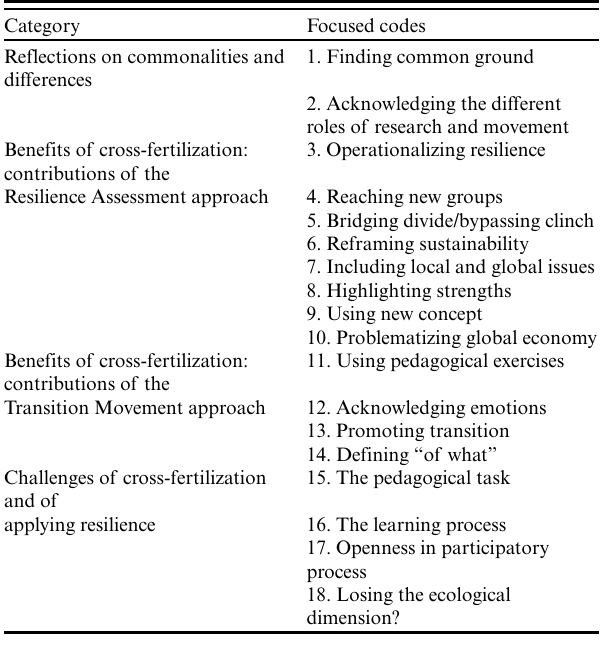
Table 2 . List of focused codes from the inductive analysis of the case study data. See descriptions of each code in Appendix 5.